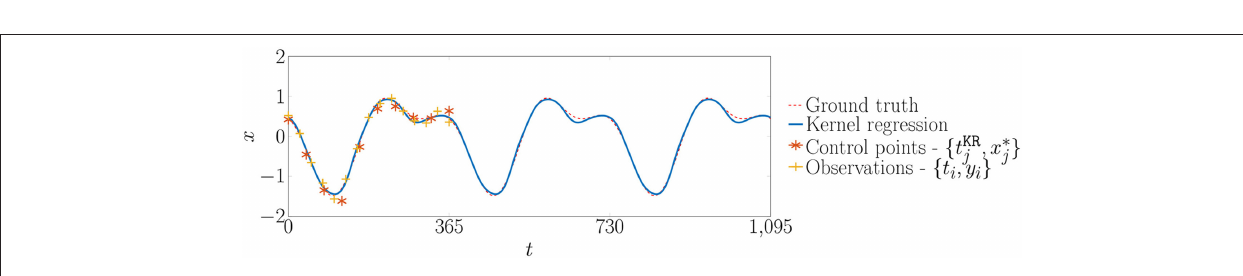
FIGURE 5 | Examples of application of kernel